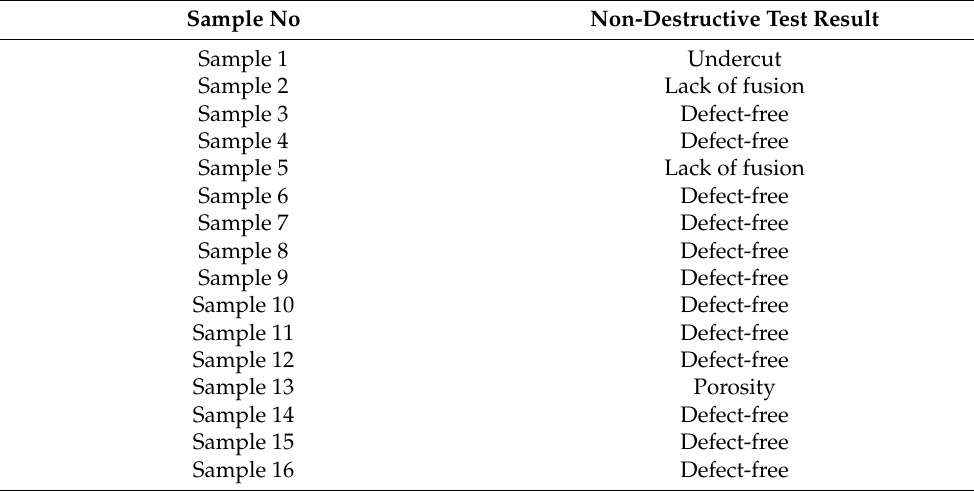
Table 5. Liquid penetrant testing result for similar TIG-welded